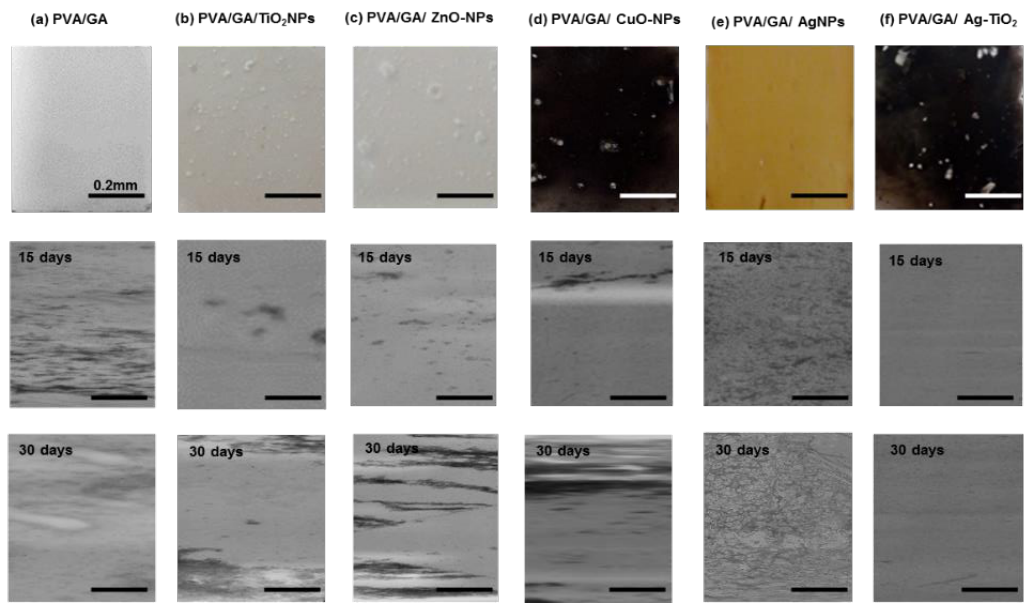
Figure 8. Qualitative antifouling assessment by optical microscopy of: ( a ) PVAGA, ( b ) PVAGA/TiO2-NPs, ( c ) PVAGA/ ZnO-NPs, ( d ) PVAGA/CuO-NPs, ( e ) PVAGA/AgNPs and ( f ) PVAGA/Ag-TiO2-NPs coatings, after 15 days and 30 days.